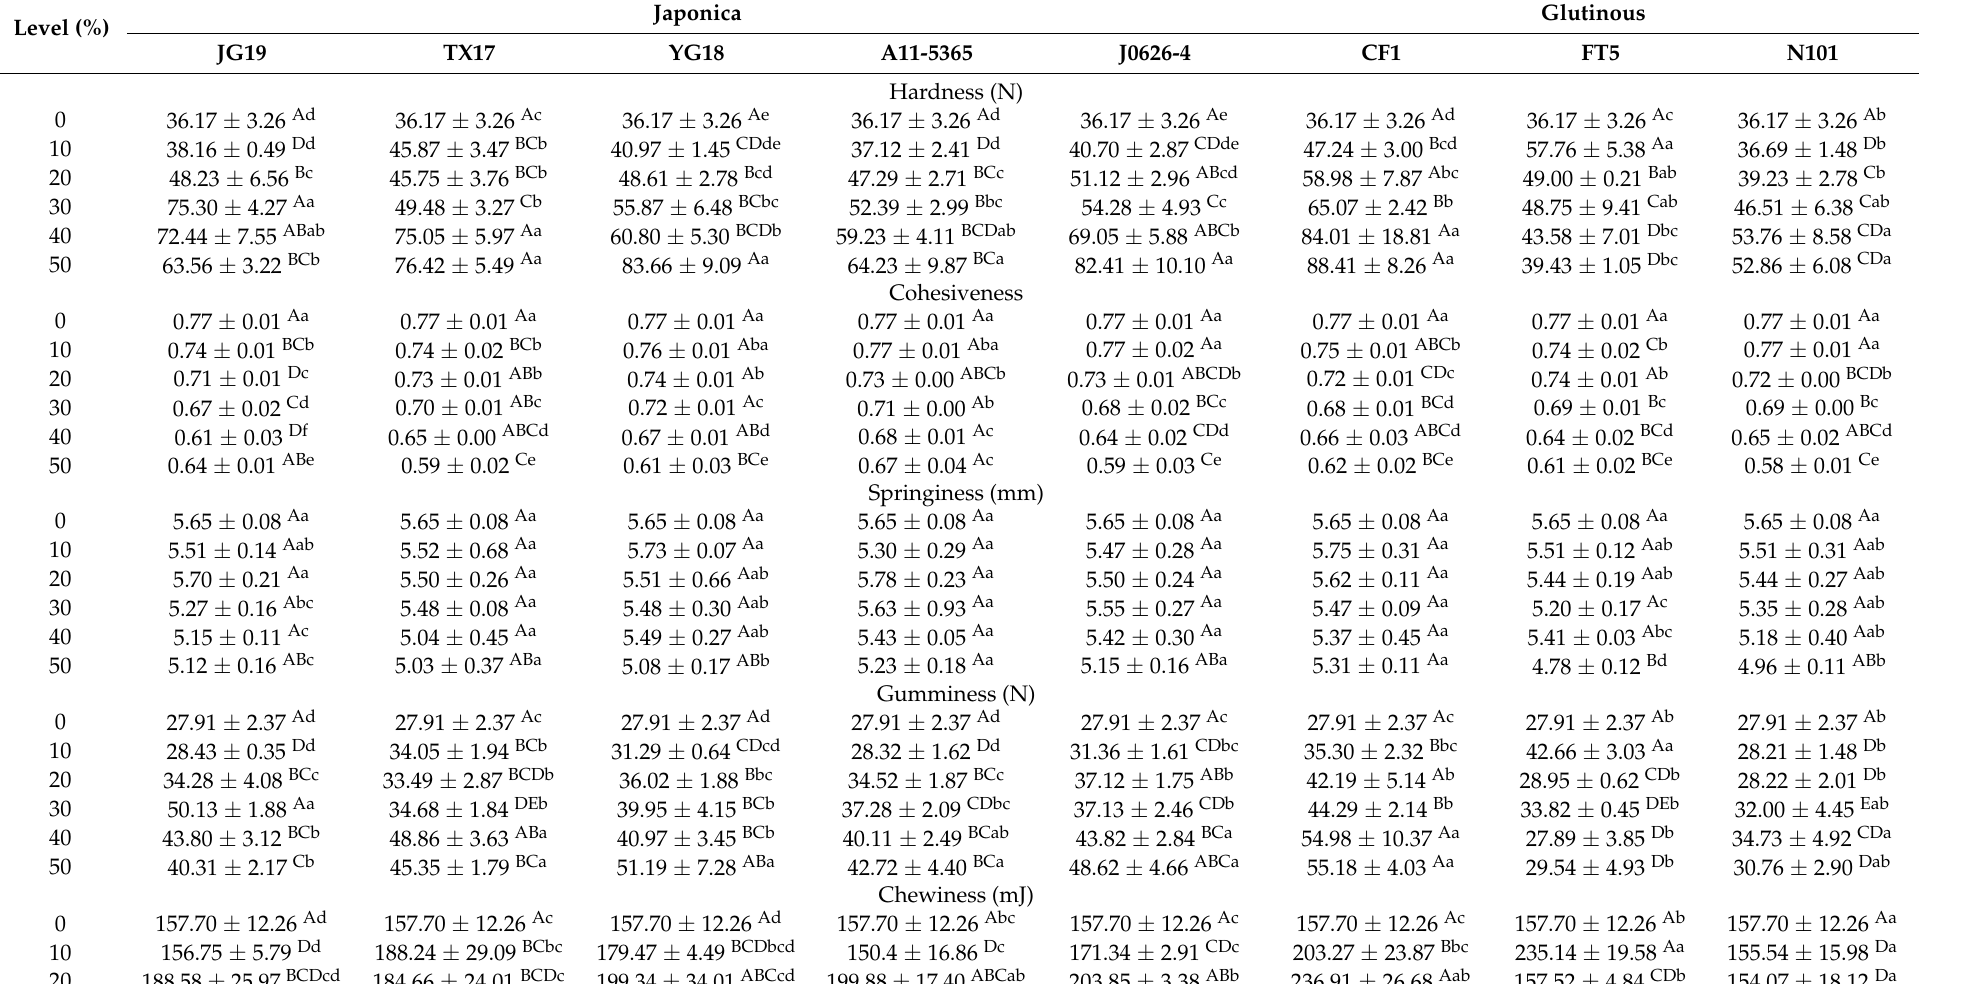
Table 3. Effect of different cultivars and addition of whole foxtail millet flour on texture properties of CSB ( n =